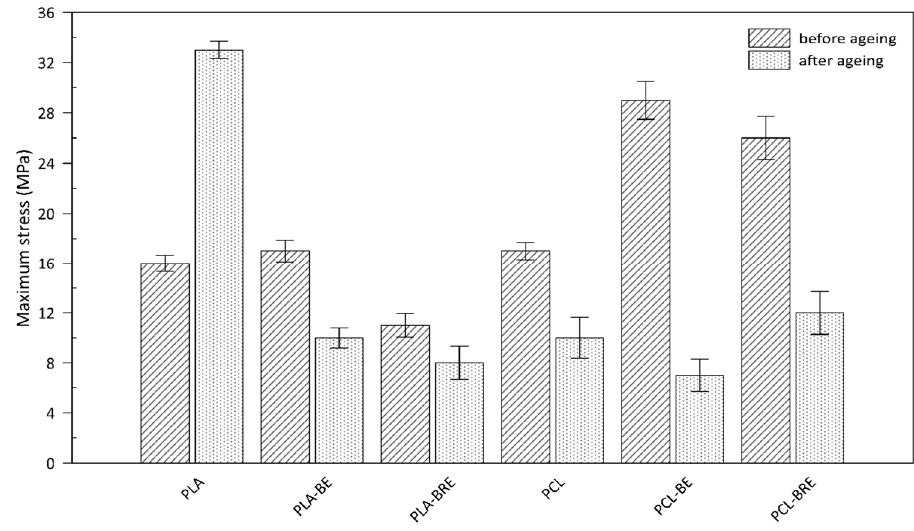
Figure 7. Mechanical properties of the PLA and PCL samples as per Young’s modulus.